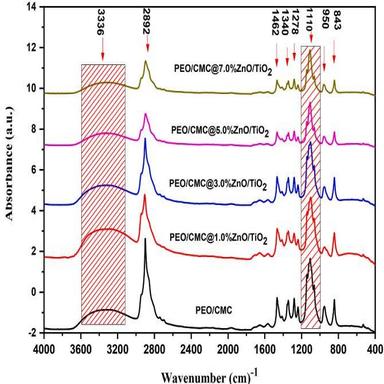
FTIR spectra of PEO/CMC blend, PEO/CMC filled with different concentrations of ZnO/TiO2 NPs.